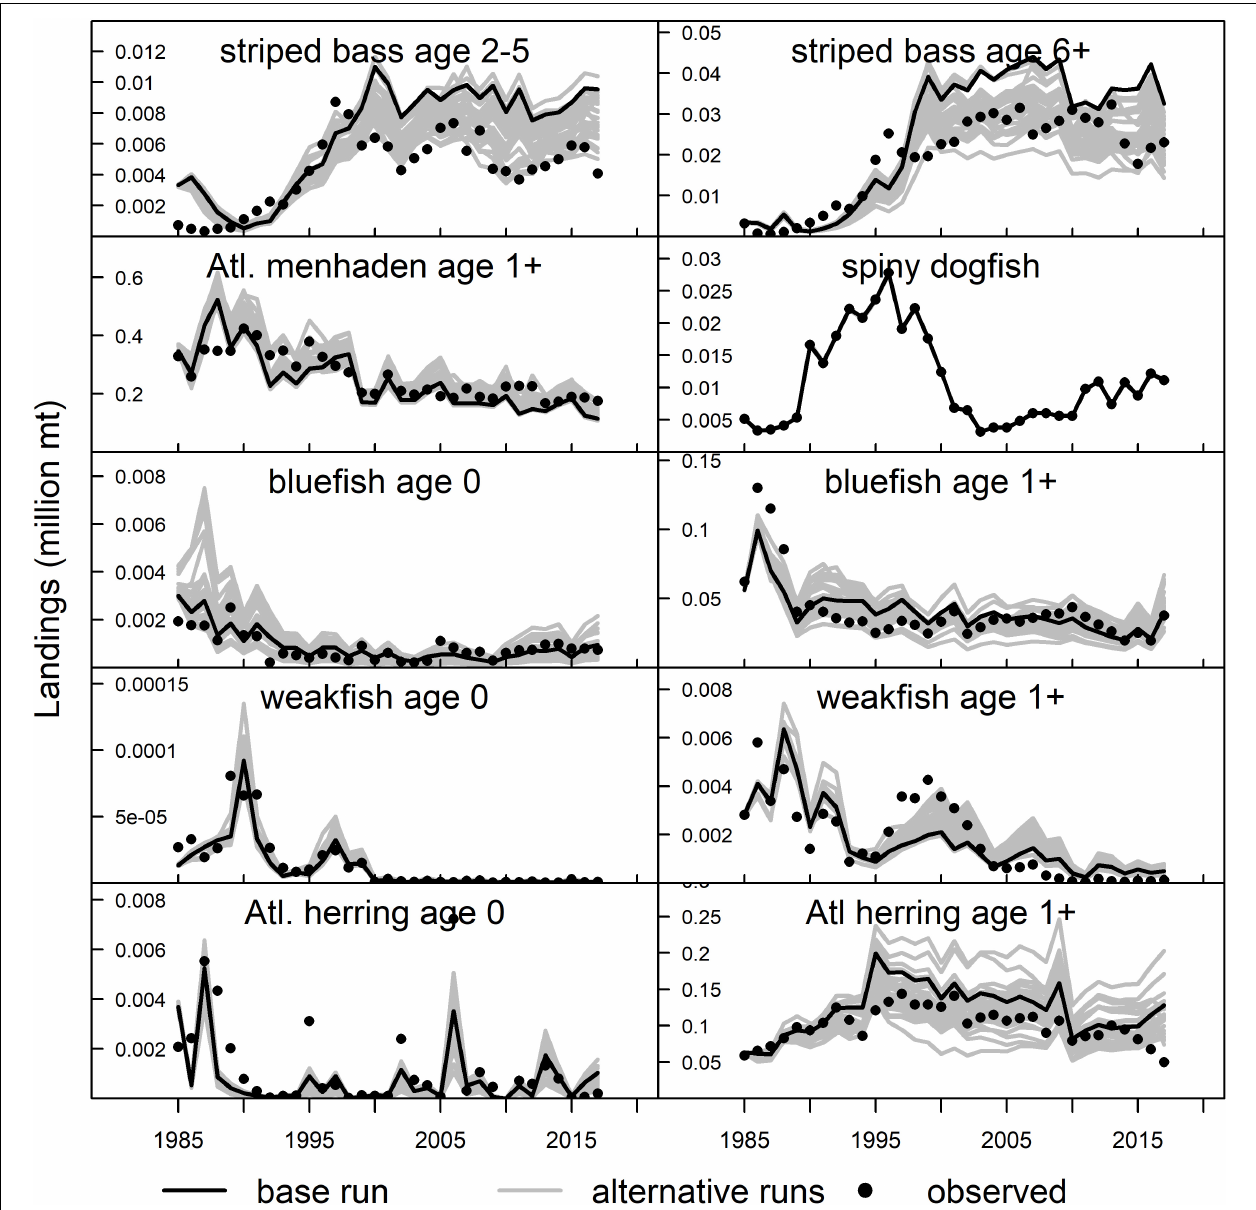
FIGURE 3 | NWACS-MICE Ecosim model fits to landings for species in the ERP complex. The solid black line is the base run model (run 8) and the gray lines are the biomass trajectories from all 32 fitted Ecosim models. The observed catch time series were aggregated from the stock assessment models.